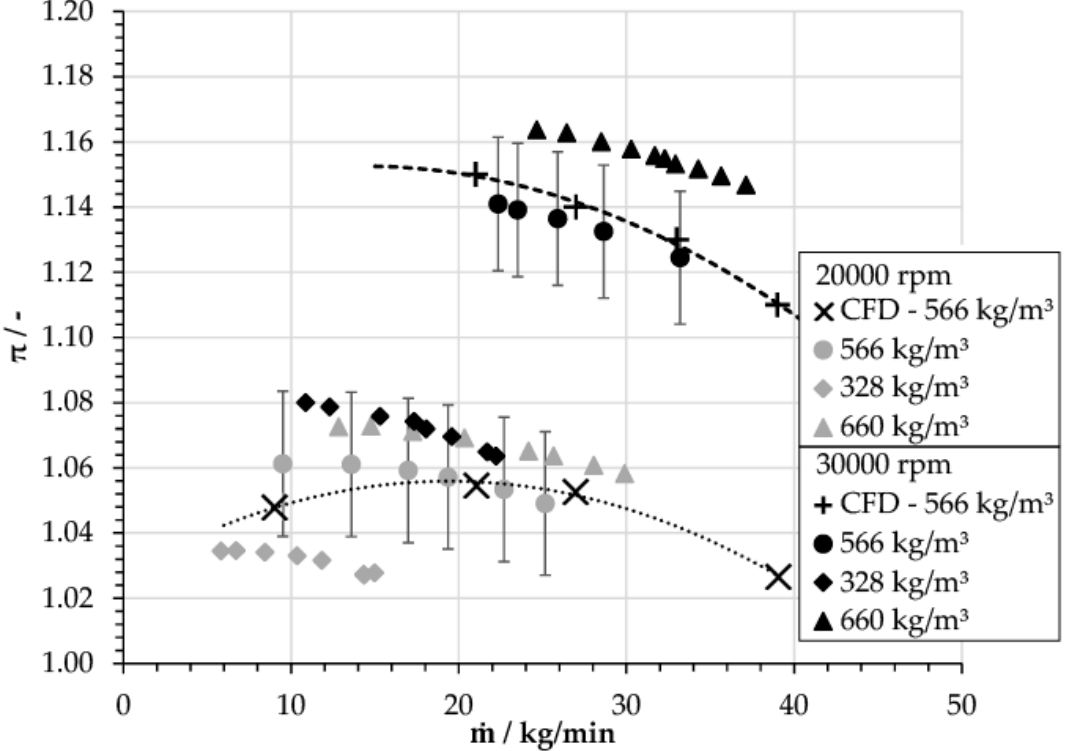
Figure 3. Performance map of the test compressor compared with CFD (computational fluid dynamics) results for varying densities.